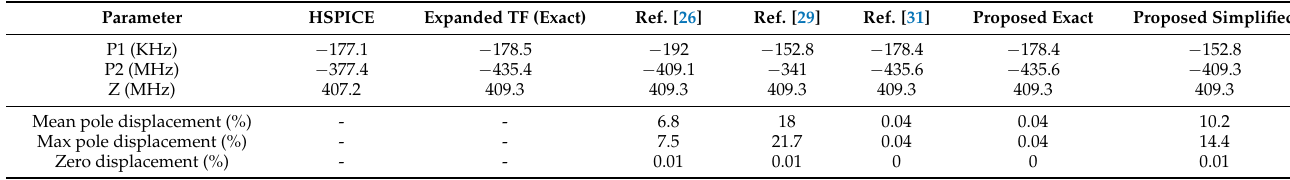
Table 7. Numerical results for Circuit